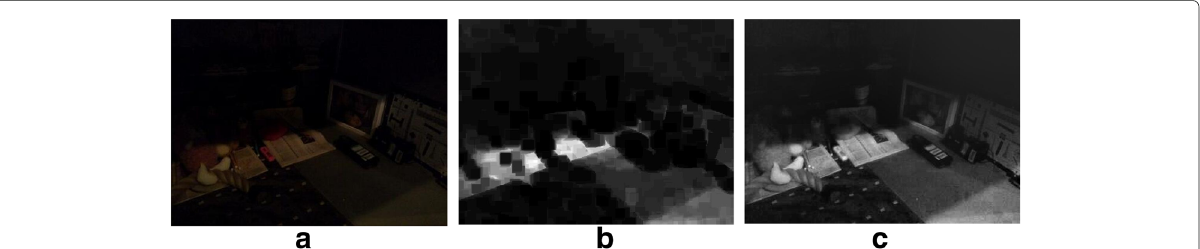
Fig. 7 Transmission refining result via guided filter. a Original image. b Transmission estimated with dual channel. c Transmission refined with guided filter